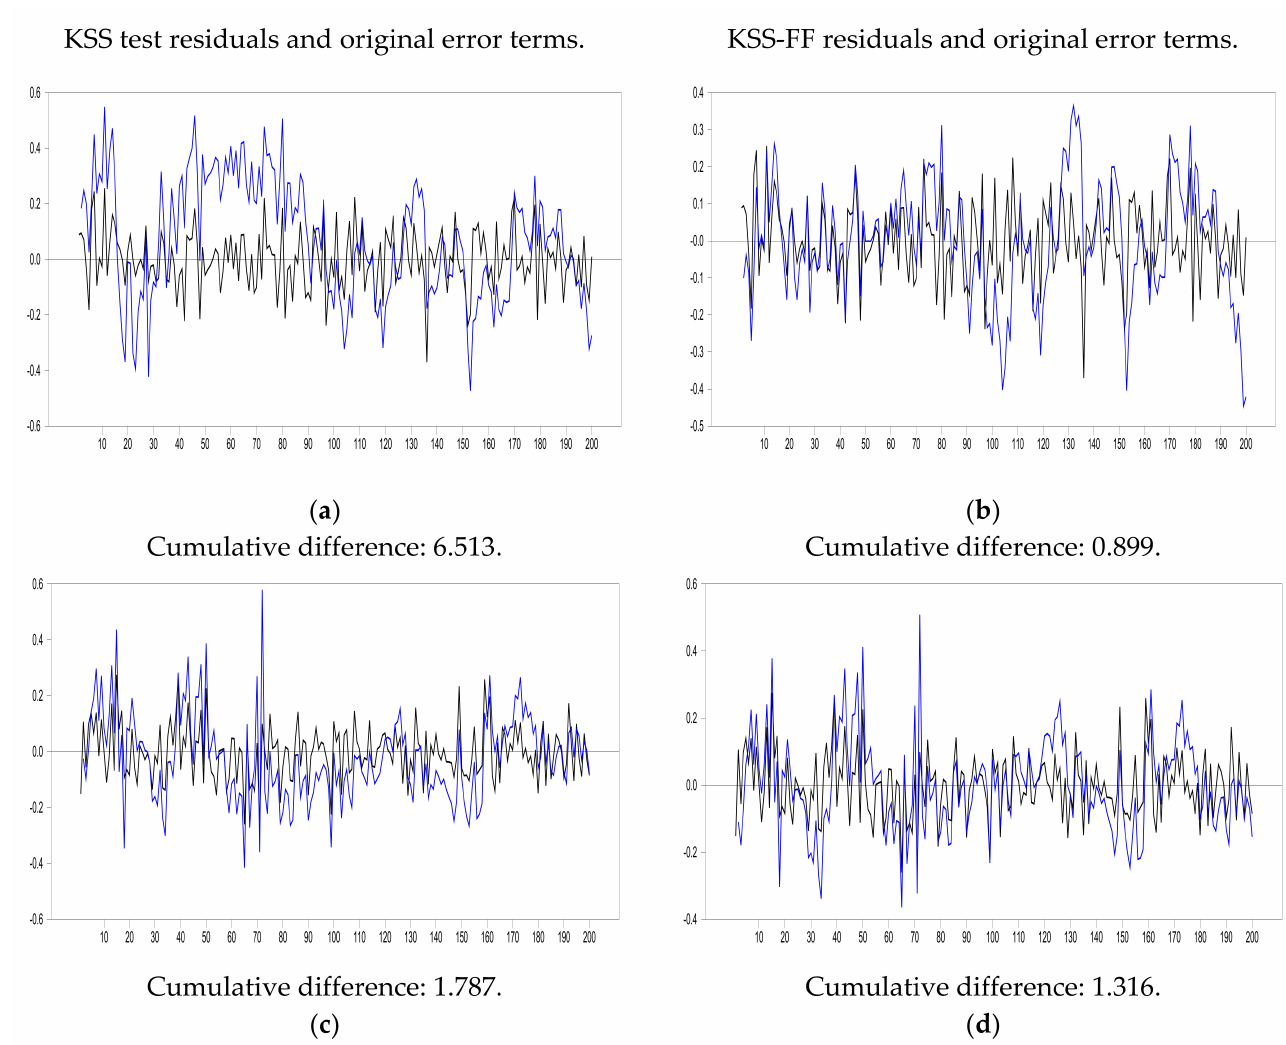
Figure 2. Residuals and original error term from KSS model and ESTAR (1) fractional Fourier: The simulation results given in Table 1 are visualized in Figure 2. KSS residuals are obtained as the squared differences between the linearized version of KSS and original series whereas the KSS-FF residuals are calculated as the squared differences between the linearized version plus the Fourier function and the original series. In each panel in Figure 2, the black lines indicate the original residuals, and the blues lines indicate the estimated KSS and KSS-FF